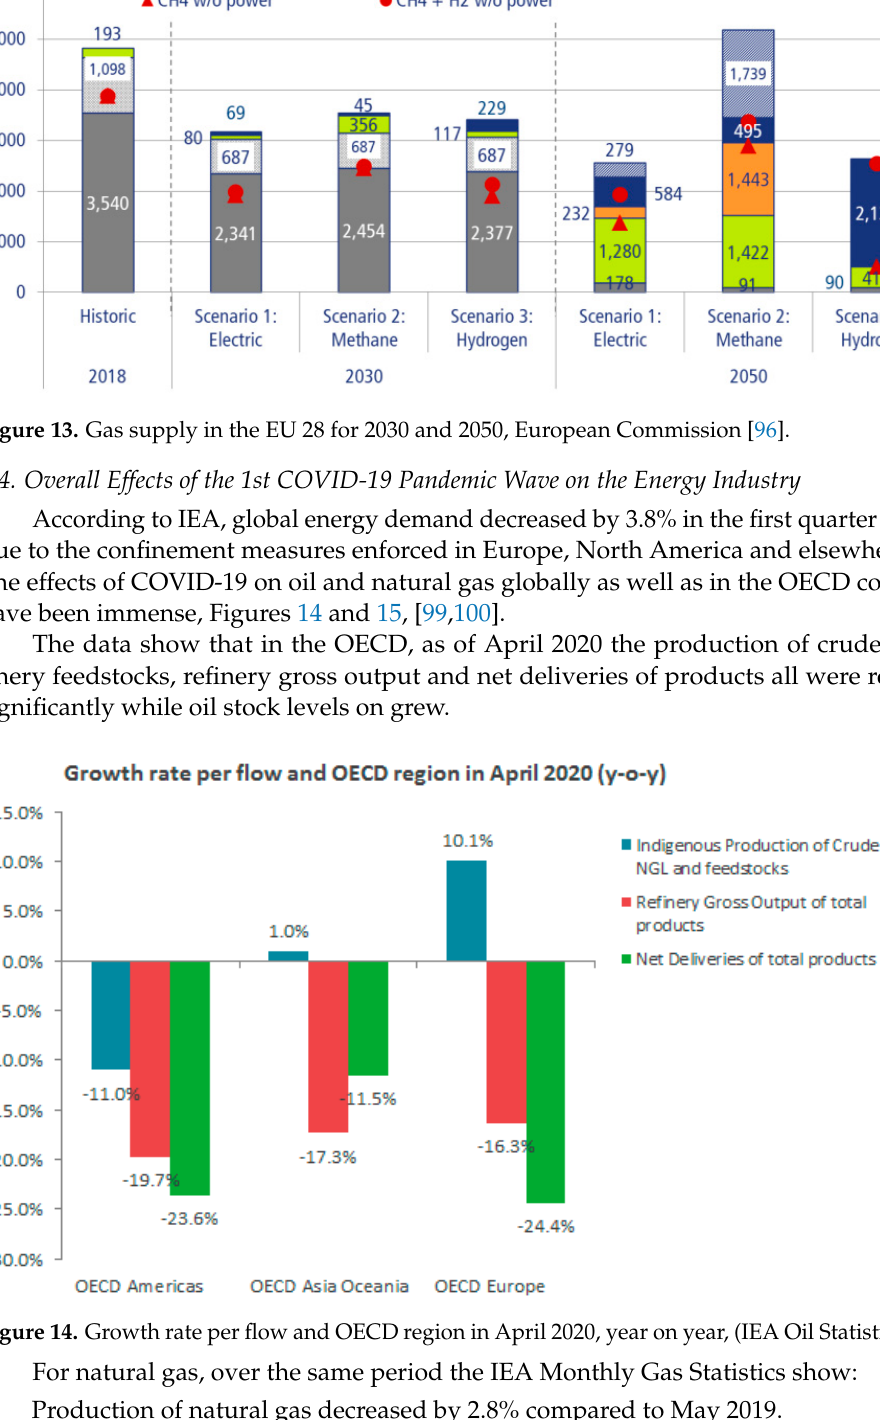
Figure 13. Gas supply in the EU 28 for 2030 and 2050, European Commission [96].